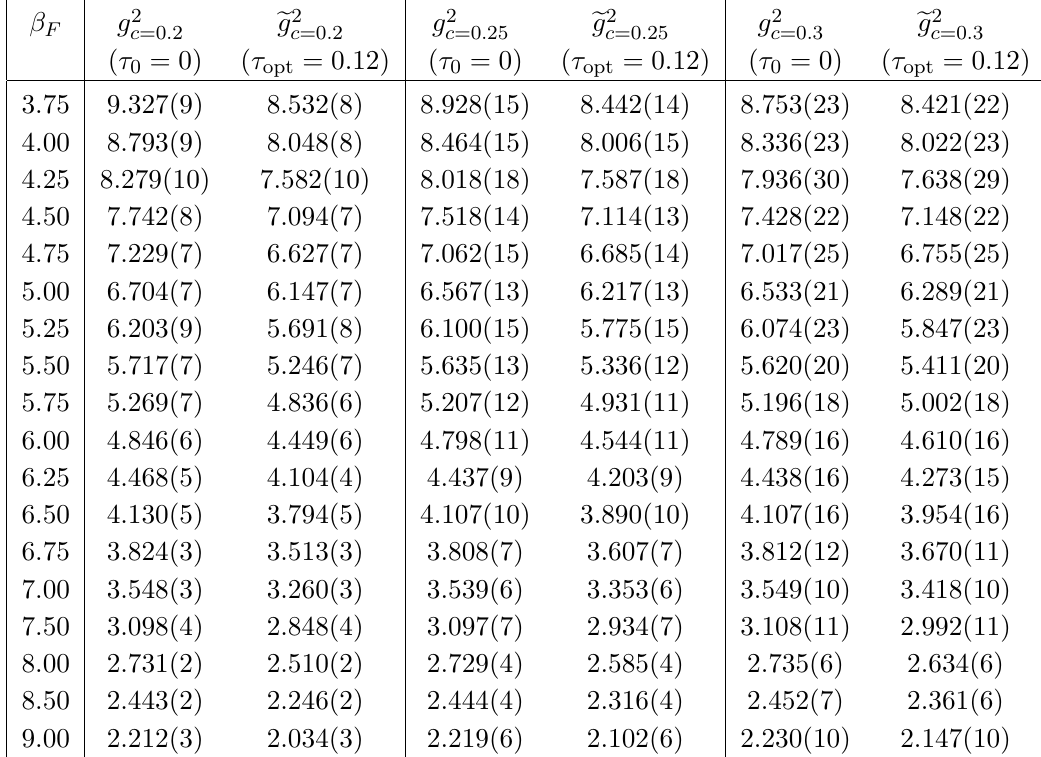
Table 19 . Renormalized gradient (cid:13)ow couplings based on the plaquette discretization of E ( t ) for the 24 4 lattice ensembles used in this work, with columns as in table 15.